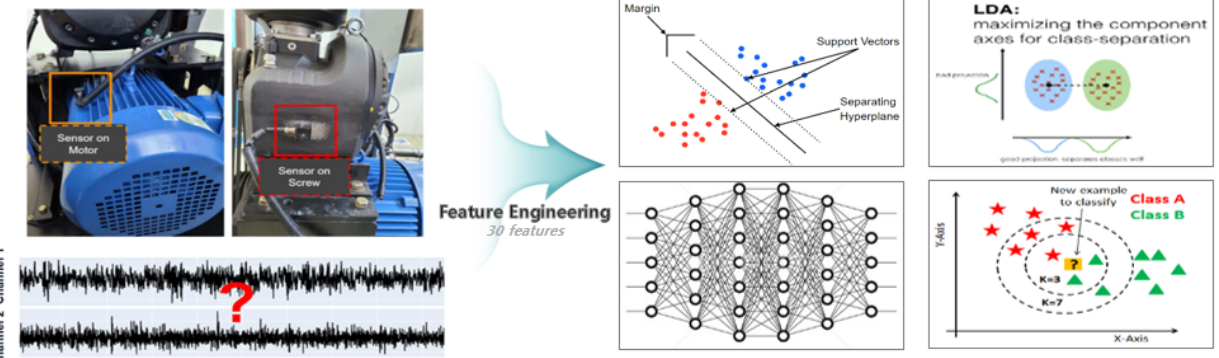
Figure 10. Machine-learning modeling.